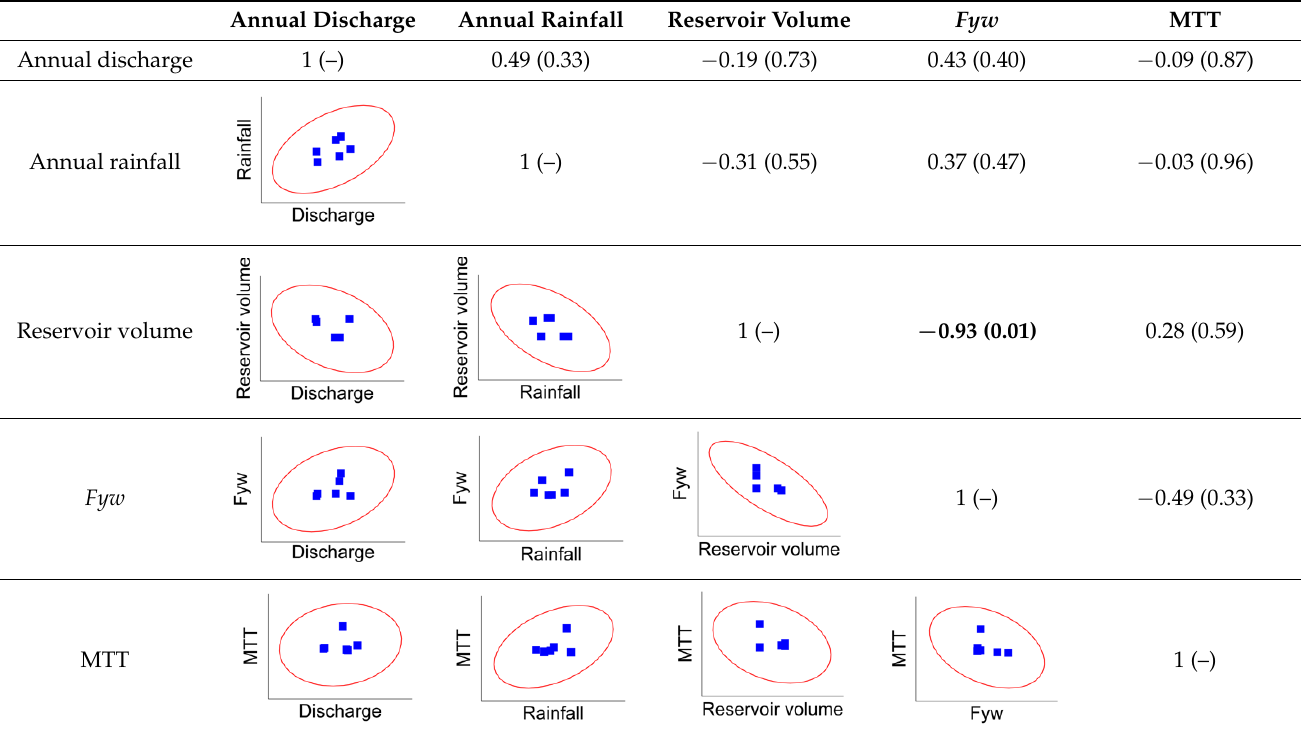
Table 2. Spearman correlation coefficients ( p -values) between forcing factors (annual rainfall, annual discharge, reservoir volume) and hydrological variables ( Fyw and MTT); data used for correlation calculation are in Appendix B.